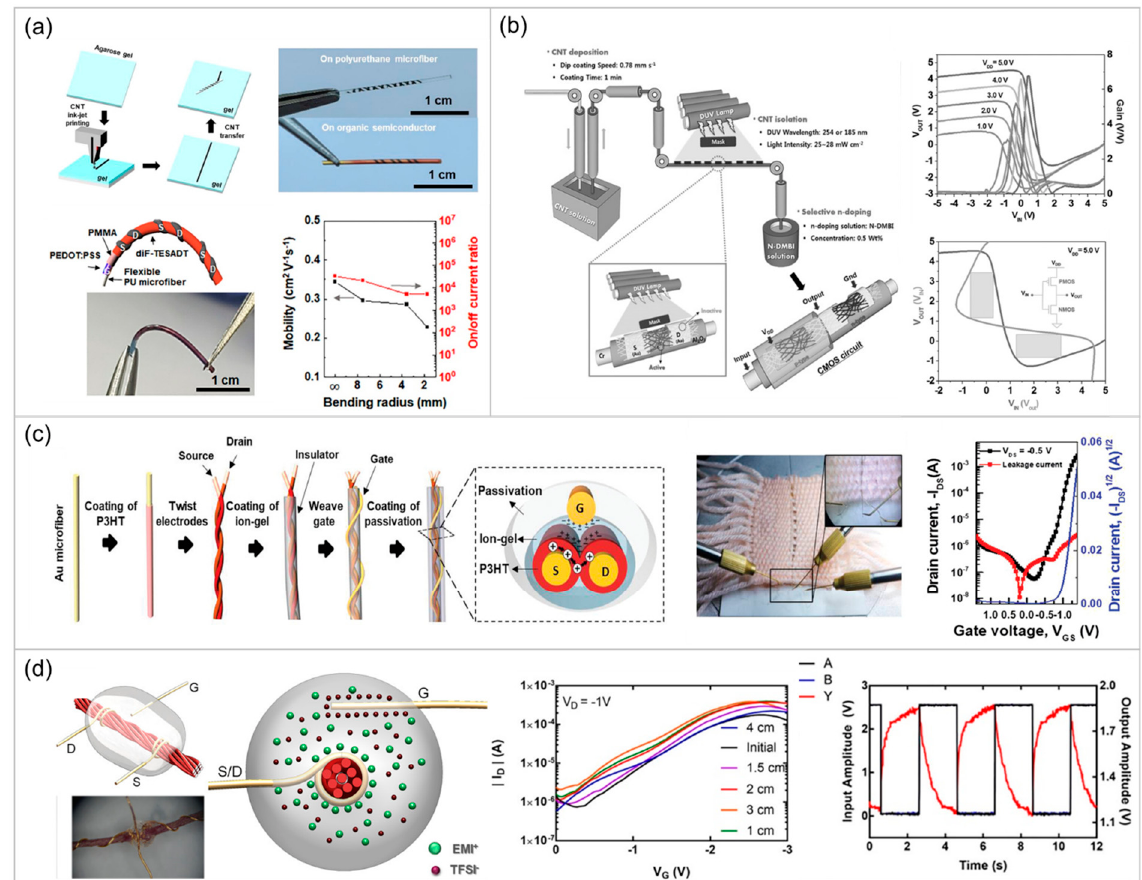
Figure 2. ( a ) Top: schematic of the rolling-transfer process of printed CNT microelectrodes (left) and photographs of the spirally wrapped CNT microelectrodes on fiber substrates (right). Bottom: schematic and photograph of a flexible fiber OFET (left), field-effect mobilities and on/off current ratio with various bending radii (right). Reproduced with permission Ref. [29]. Copyright 2020, American Chemical Society. ( b ) Left: schematic illustration of a fabrication process for fiber-shaped CMOS circuitry. Right: electrical properties of the 1D complementary inverters. Reproduced with permission Ref. [22]. Copyright 2017, Wiley-VCH. ( c ) Left: schematic illustration of a fabrication process of a fiber-shaped OFET with the twisted structure and a solid ion-gel electrolyte. Right: photograph and transfer characteristics of the fiber-shaped OFET embedded in a fabric. Reproduced with permission Ref. [30]. Copyright 2019, Wiley-VCH. ( d ) Left: schematic illustration and photograph of the ionogel-gated fiber transistor. Middle: transfer characteristics of the ionogel-gated transistor with different bending radii. Right: electrical characteristics of logic gate NAND (A and B curves: two logic gate inputs, Y curve: output from the circuit). Reproduced with permission Ref. [26]. Copyright 2019, American Chemical Society.